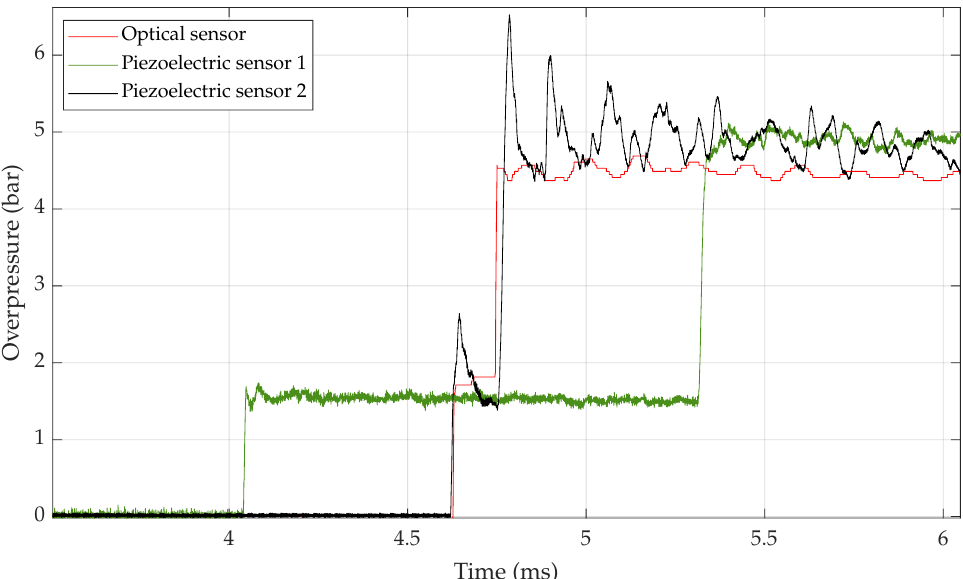
Figure 4. Zoom on the two steps of pressure P 2 and P 5 . Comparison between the reference piezoelec- tric sensors and the 20 MHz SMI sensor after signal